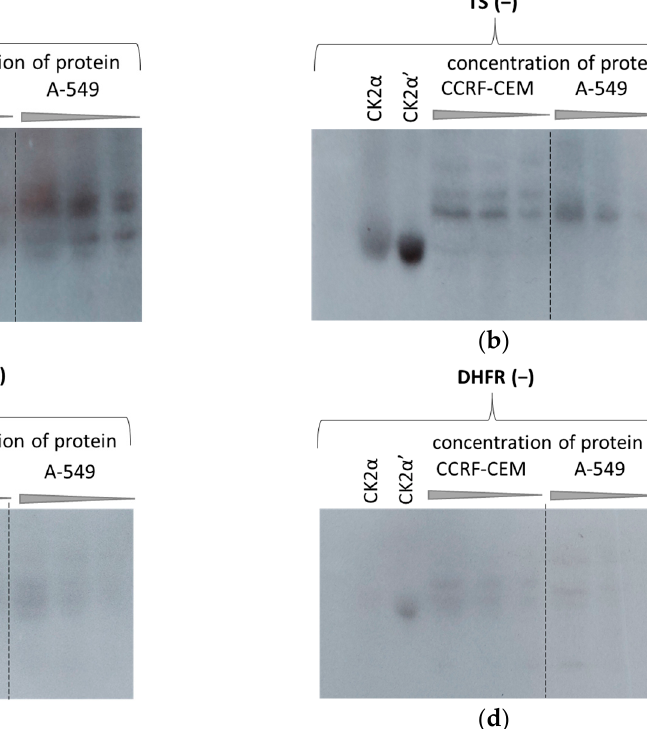
Figure 5. In-gel kinase assay results for TS ( a ) and DHFR ( c ). CCRF-CEM and A-549 lysates were prepared in NP-40 buffer (20 mM Tris-HCl pH 8.0; 137 mM NaCl; 1% Nonidet P-40; 2 mM EDTA). The left parts of ( a ) and ( c ) represent a fragment of gel stained with CBB with visible protein markers (M, PageRuler Prestained Protein Ladder, Thermo Scientific) and recombinant forms of CK2 α and CK2 α ’. Human recombinant catalytic subunits of CK2, i.e., CK2 α (29 µg) and CK2 α ’ (8 µg), were used as positive controls. Lysates containing proteins at three different levels were loaded in the range of 89–22 µg/well. Co-polymerisation of TS and DHFR was at acrylamide:bis-acrylamide ratio 37.5:1 and 19:1, respectively. Autoradiograms shown in ( a – b ), and ( c – d ) were obtained after 18 h and 6 h of X-ray films exposure, respectively.